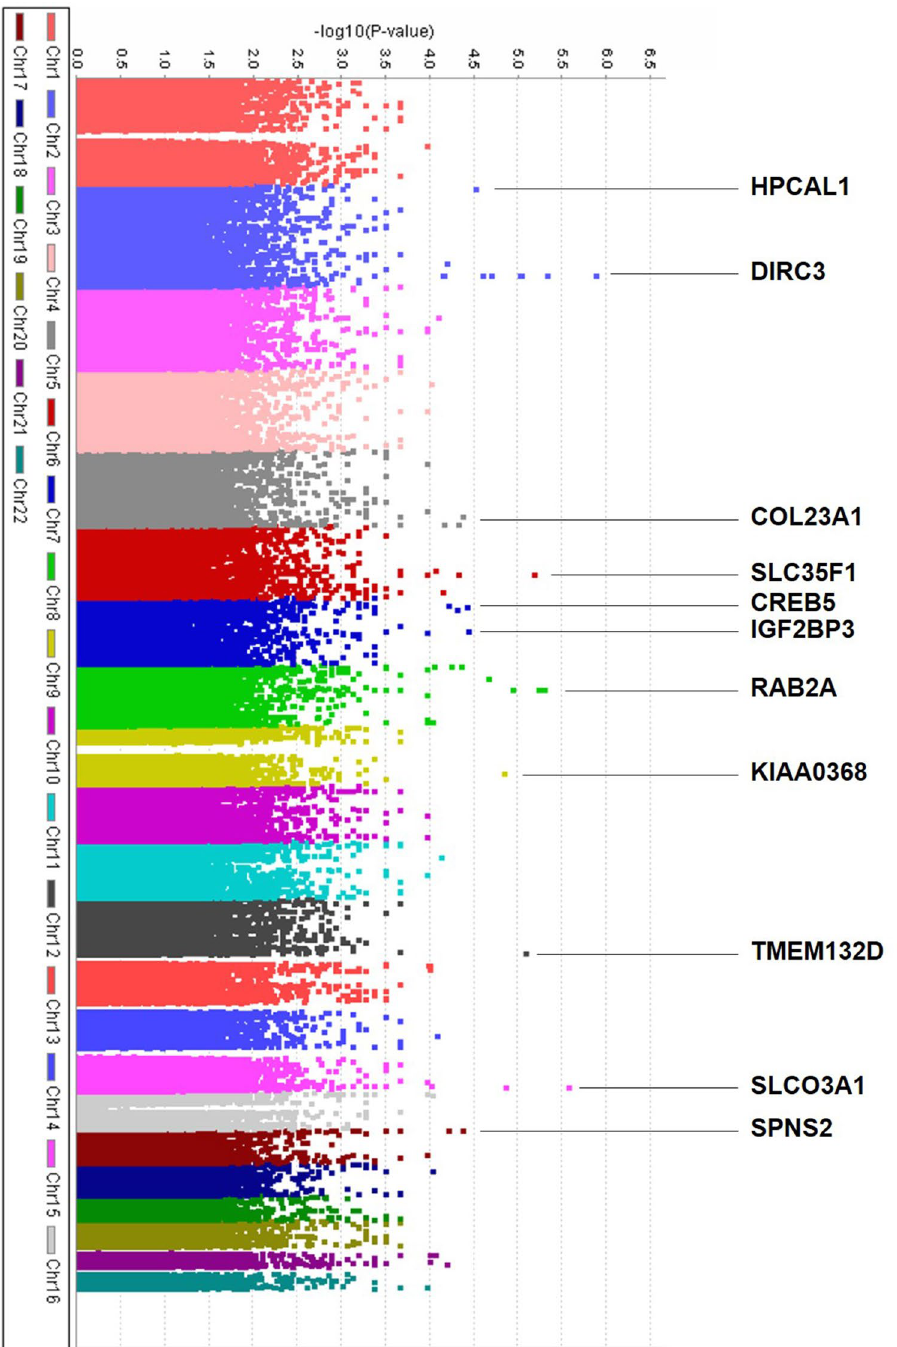
Figure 2. Genome-wide association analysis results of treatment response to intravitreal anti-VEGF injection to treat DME in Korean patients. Relatively significant loci are displayed with locus names ( p < 5.0 × 10 –5